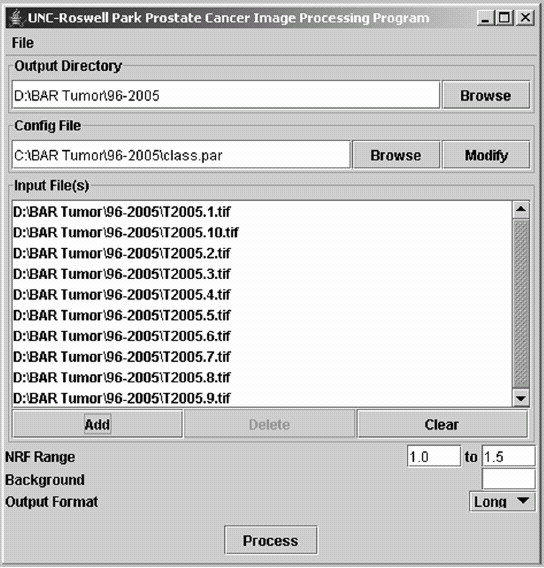
Graphical user interface (GUI) of the image analysis software.